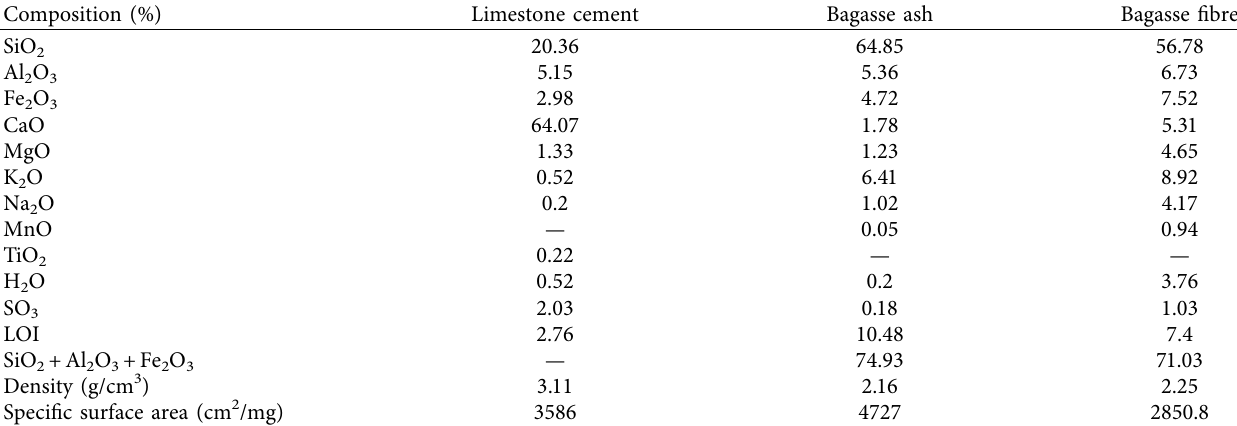
Table 1: Chemical and physical properties of lime and Costus englerianus